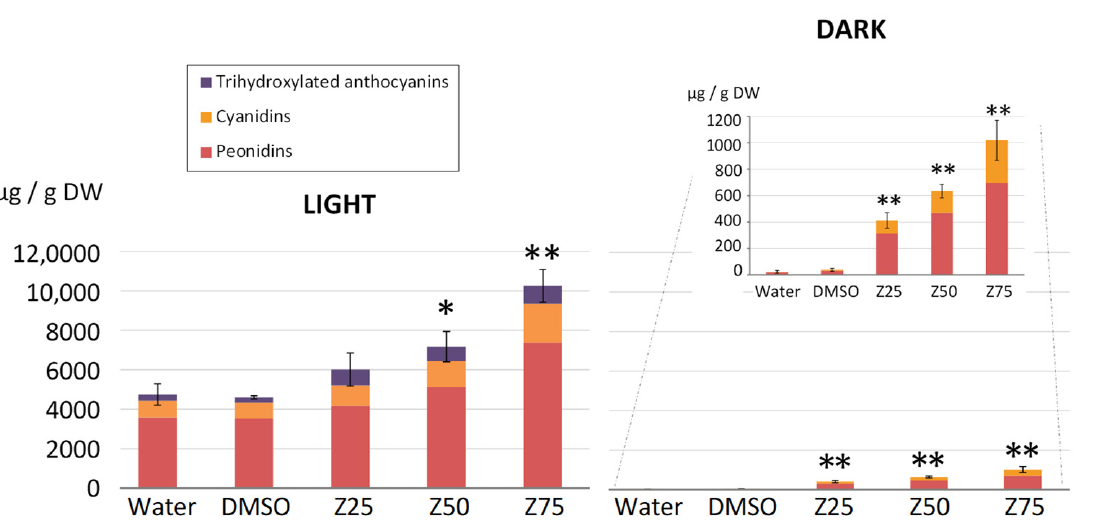
Figure 4. Analysis of zebularine impact on anthocyanin accumulation in the light and in the dark. Treatments with zebularine were performed 3 days after sub-culturing. Nine days after zebularine addition, cells were harvested, and anthocyanins were quantified. Cell total anthocyanin content was calculated as the sum of each individual anthocyanin. Values are the mean ± SD of three biological replicates. Asterisks indicate significant difference s in the total amounts of anthocyanins, as determined by a Welsh’s t -test (n = 3 ) based on the mean differences between zebularine-treated and DMSO-treated samples (* p < 0.05; ** p < 0.01). The quantities of peonidins, cyanidins, and trihydroxylated anthocyanins in each condition are indicated in the bars.